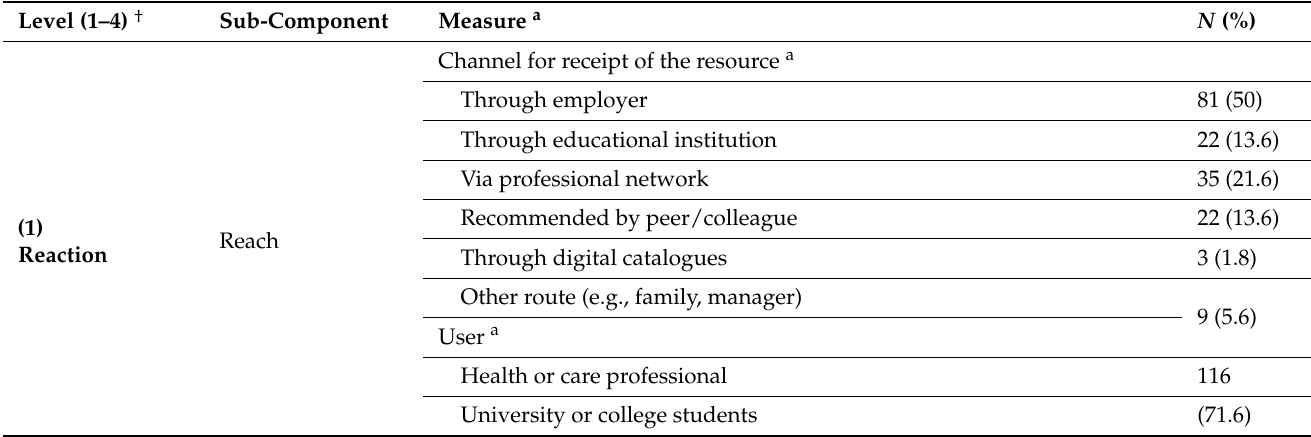
Table 3. Mixed-methods analysis aligned with the New World Kirkpatrick Evaluation